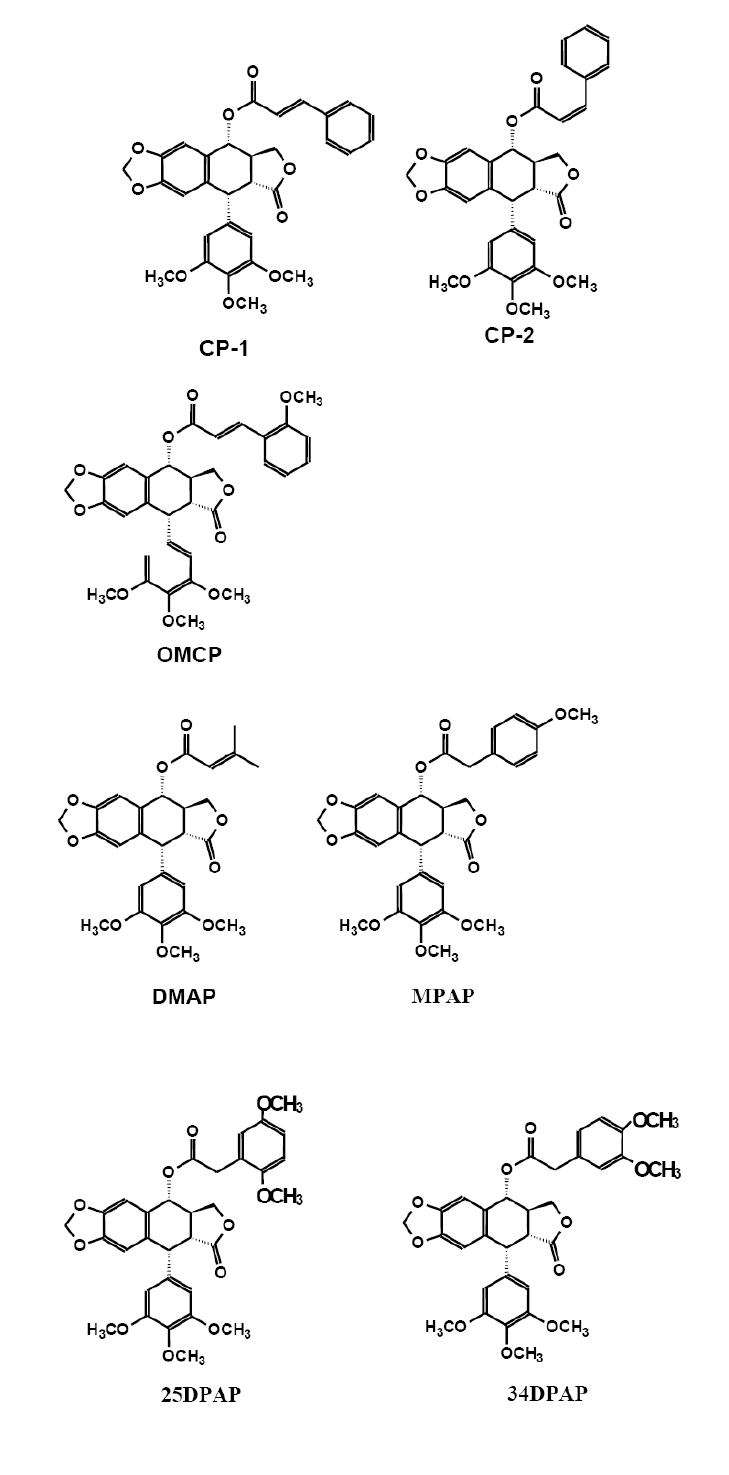
Fig. 2 Structure of podophylotoxin